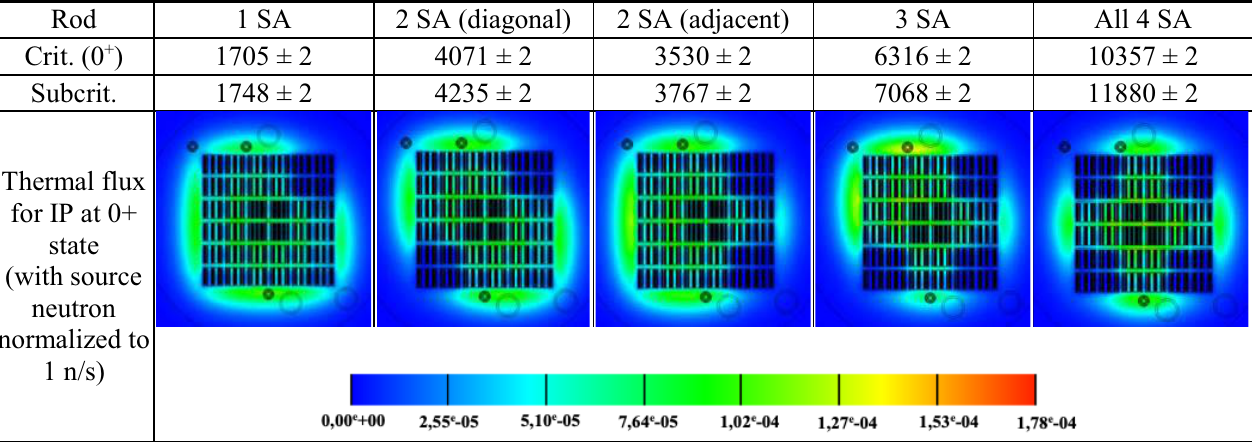
Rod 1 SA 2 SA (diagonal) 2 SA (adjacent) 3 SA All 4 SA Crit. (0 + )